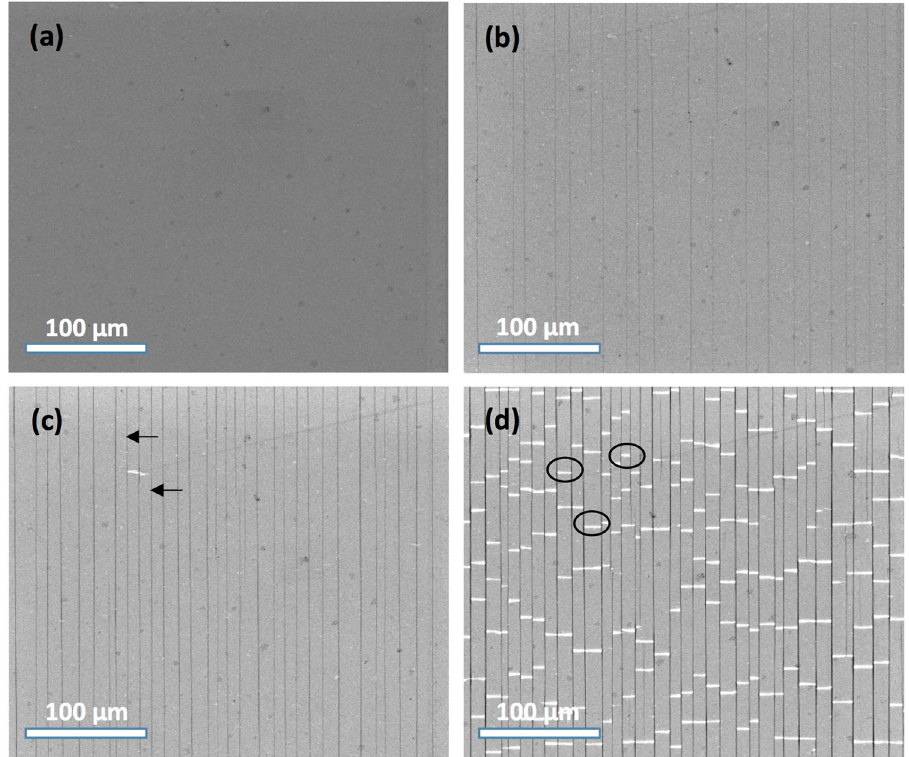
Fig. 6 In-situ SEM images acquired during micro-tensile testing of a typical IPP stacked structure. Average strain values prescribed on the IPP structure are: ( a ) 1.67%, ( b ) 3.33%, ( c ) 6.67%, and ( d ) 10%, respectively. Arrows: channel cracks, circles: secondary cracks and localized